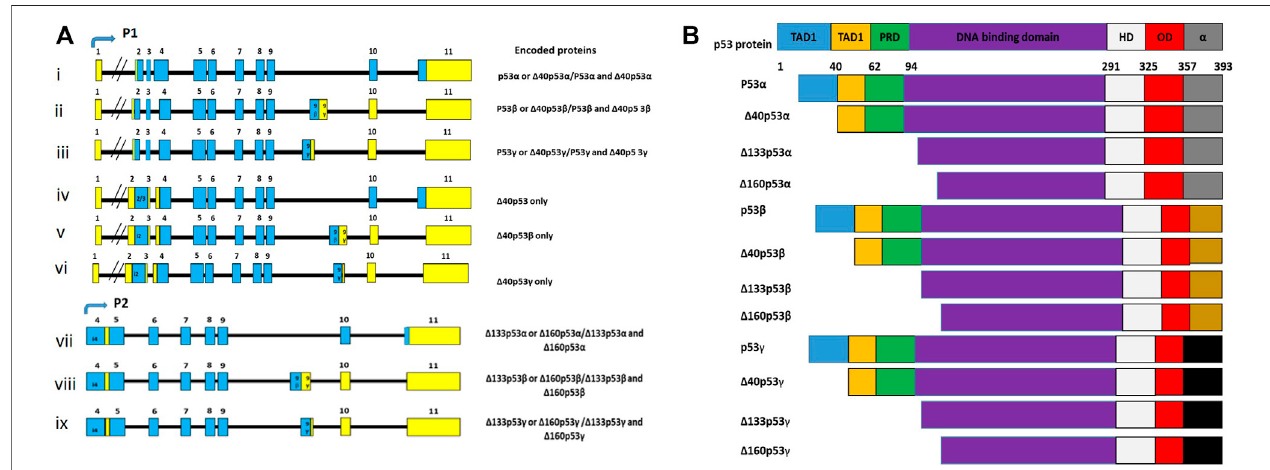
FIGURE 2 | (A) TP53 mRNA transcripts, coding exons (blue), noncoding exons (yellow) and alternative exons (i). Although there are 15 transcripts encoded in the TP53 gene, only 9 transcripts are often presented because some code for the same protein isoforms. (B) There are 12 different p53 isoforms, containing various combination of the different domains, which include the transactivation domain 1 (TAD1), the transactivation domain 2 (TAD2), the DNA binding domain (DBD), the proline-richdomain(PRD),theoligomerizationdomain(OD),thehingedomain(HD),andthenegativeregulationdomain( α ).AdaptedfromAnbarasanandBourdon